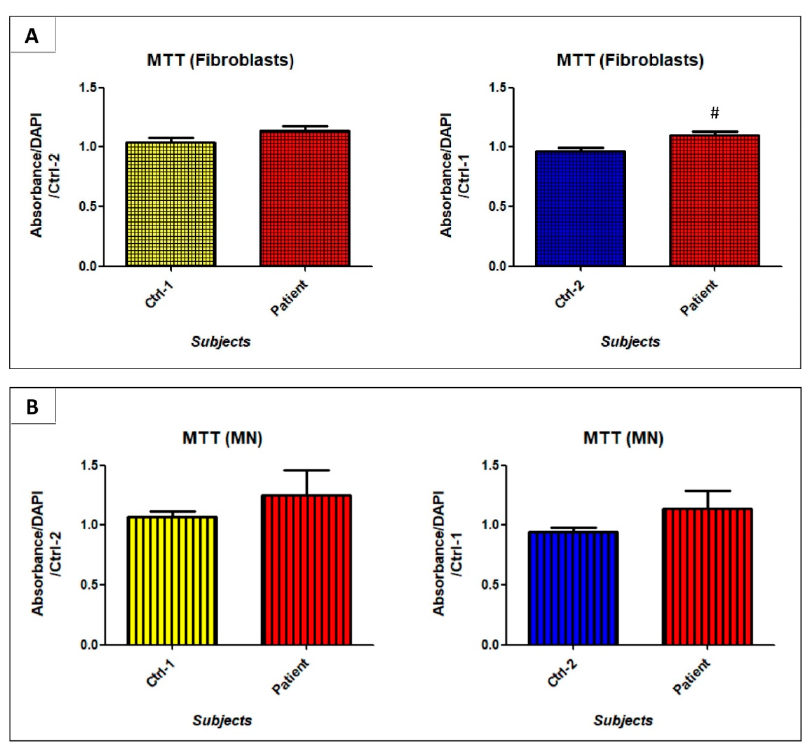
Figure 10. Succinate dehydrogenase activity evaluated in fibroblasts ( A ) and MNs ( B ) of Ctrl-1, Ctrl-2, and patient. # p < 0.05 vs. Ctrl-2.